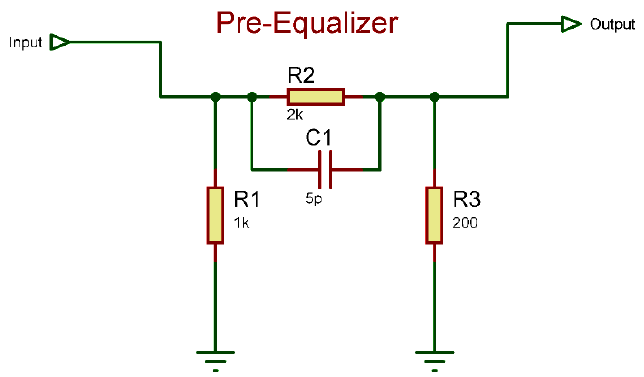
Figure 6. RC Pre-Equalizer circuit diagram (schematics).